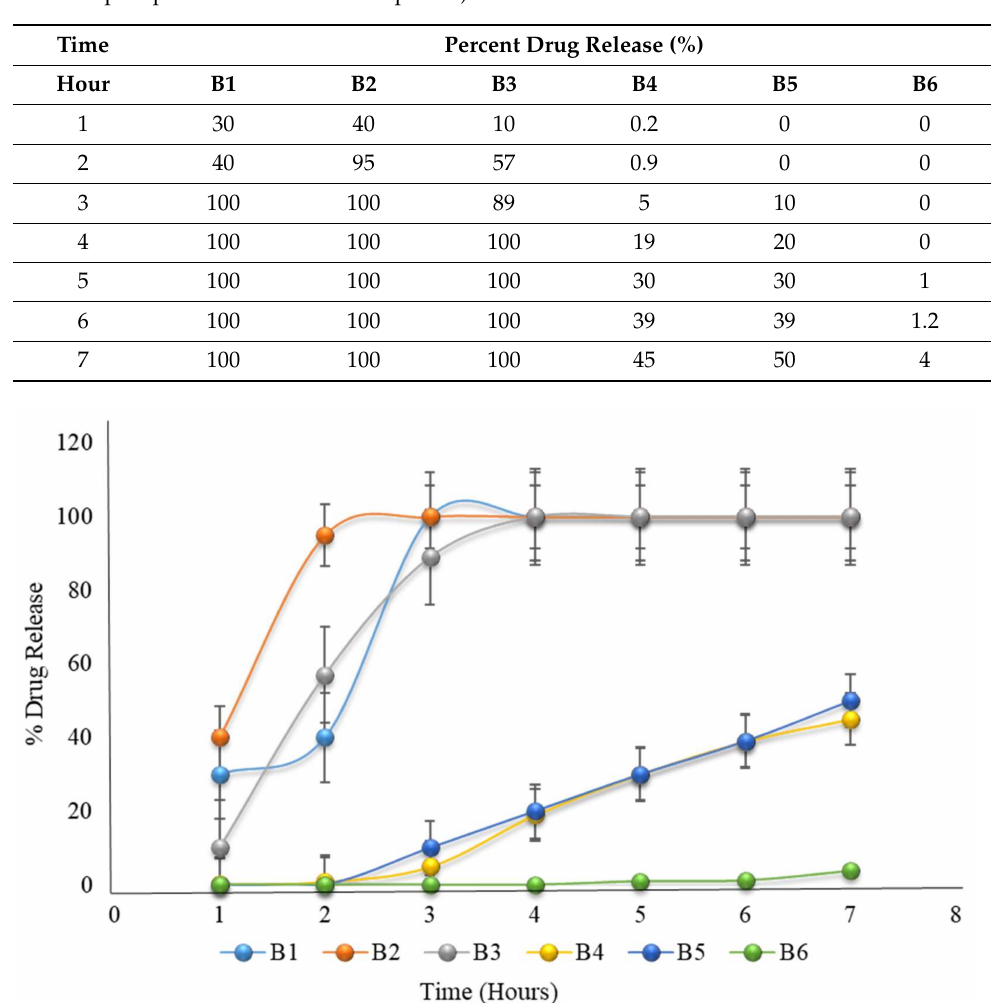
Figure 3. The in vitro dissolution of formulations B1 to B6 (the first 2 h in an acidic medium of pH 1.2, then in a phosphate buffer medium of pH 6.8) mimicked that of the formulations B1 to B3, which had 100% drug release, though formulations B4 to B6 failed to completely release before 6